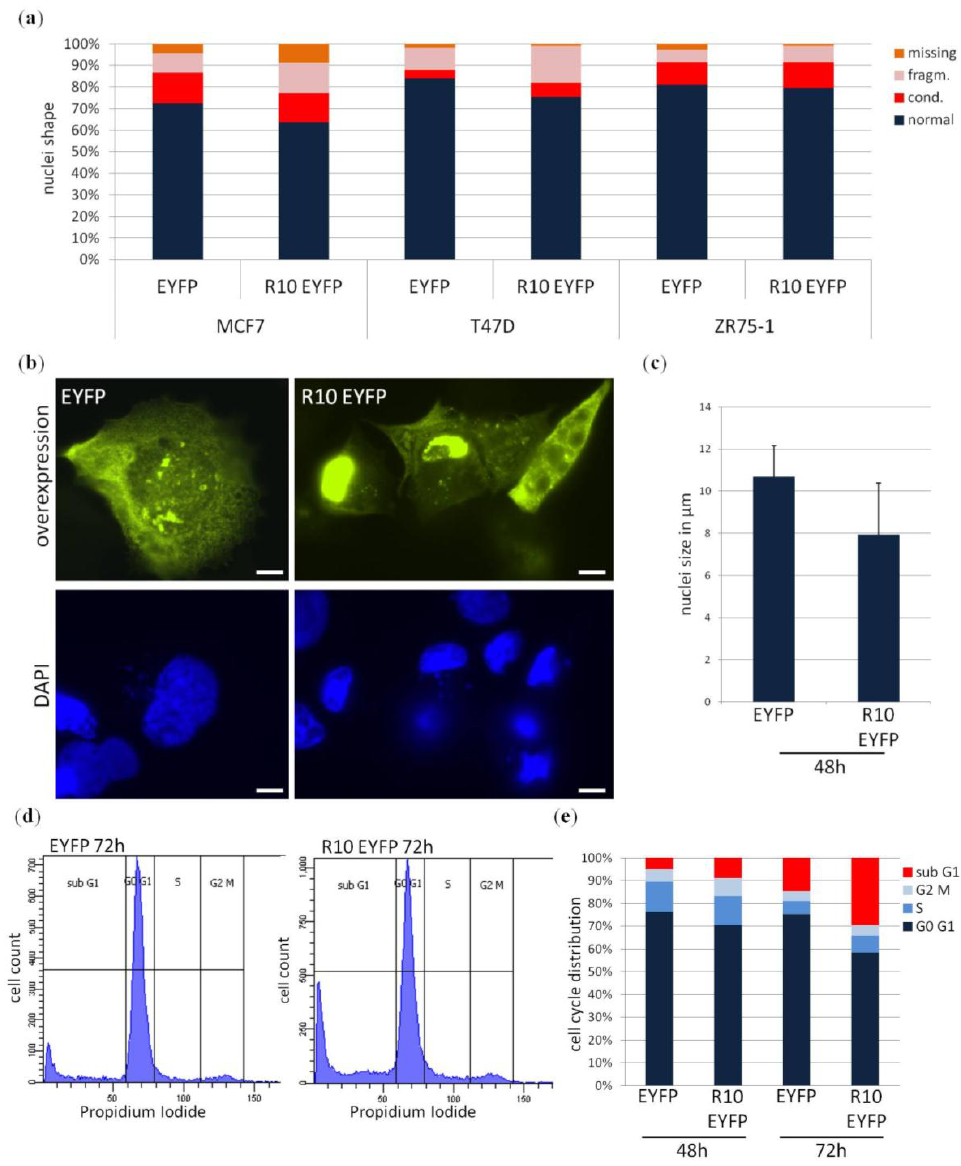
Figure 5. RASSF10 induces apoptosis in breast cancer cell lines. Overexpression of EYFP or RASSF10-EYFP in breast cancer cell lines induces morphological changes and DNA fragmentation associated with apoptosis induction. ( a ) Breast cancer cell lines MCF7, T47D and ZR75-1 exhibit alteration of nuclei shape after RASSF10 overexpression. Cells were analysed 72 h post transfection according to nuclei shape as normal, condensed, fragmented or missing ( n = 100); ( b ) MCF7 cells show reduced nuclei size after RASSF10-EYFP transfections (5 μm standard) and ( c ) according nuclei measurements are shown ( n = 17); ( d and e ) RASSF10 overexpression for 48 h or 72 h increases sub G1 fraction of transfected cells in flow cytometry analysis ( n > 8000) using propidium iodide staining of DNA. In the breast cancer cell line ZR75-1, unmethylated at the RASSF10 promoter, overexpression of RASSF10 had no effect on nuclei morphology (Figure 5a). We observed that RASSF10 overexpression